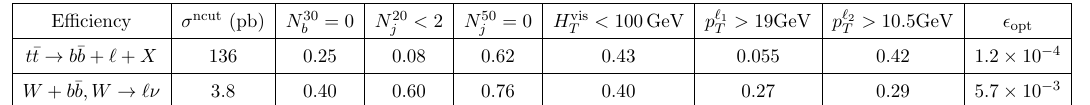
Table 1 . The selection e(cid:14)ciency for the two dominant SM backgrounds t (cid:22) t with only one top quark decaying leptonically and W + b (cid:22) b with W decaying leptonically. The e(cid:14)ciencies reported in the table are the additional suppression with respect to all the previous cuts, and (cid:15) opt is the total